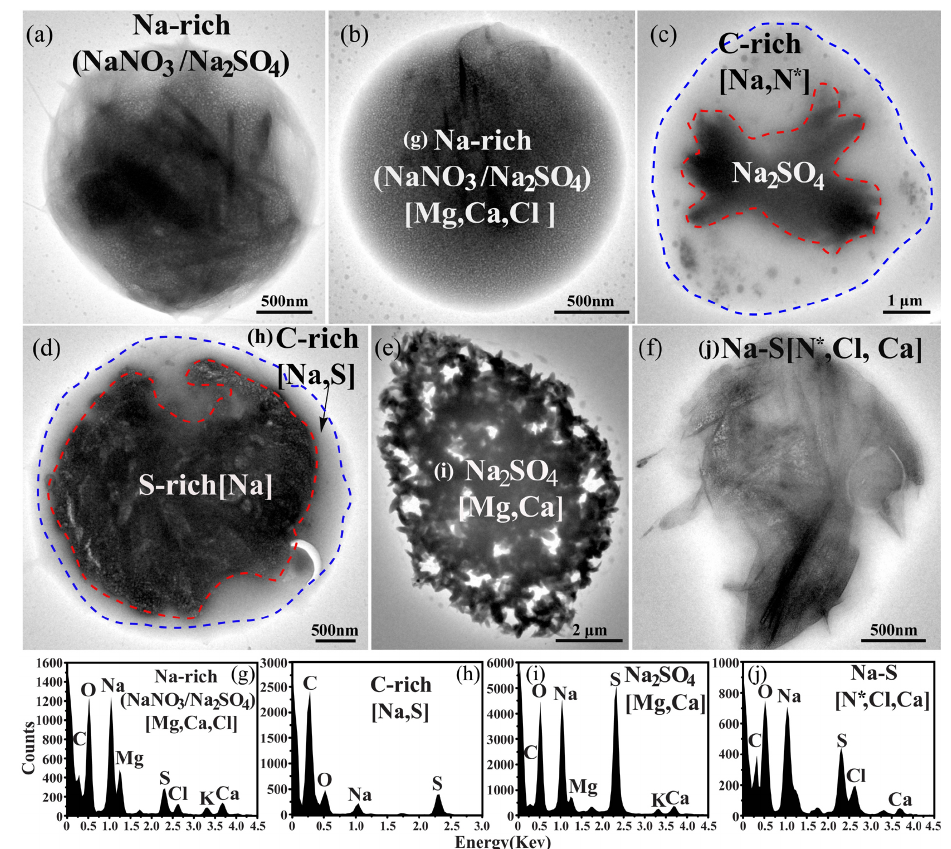
Figure 4. TEM images and EDX spectra of the typical fully aged SSA. Major species are shown in parentheses, and minor elements are in square brackets. ( a and b ) This Na-rich particle contains mostly Na, O, N, and S. The rod-like aggregates are Na 2 SO 4 and the species of the non-defined shape are NaNO 3 . The NaNO 3 -containing coating is more sensitive to the strong electron beam than the Na 2 SO 4 . ( c and d ) Na-rich particles mainly contain C, N, O, Na, and S. One typical transparent coating with high C and minor O, Na, S or N was stable under a strong electron beam, suggesting a possible organic coating. ( e and f ) The particles mainly contain Na, O, and S. Many small rod-like Na 2 SO 4 gather together to form one particle. (g–j) EDX spectra of one selected part within individual SSA marked in TEM images. N cannot be directly measured but is inferred based on elemental composition in